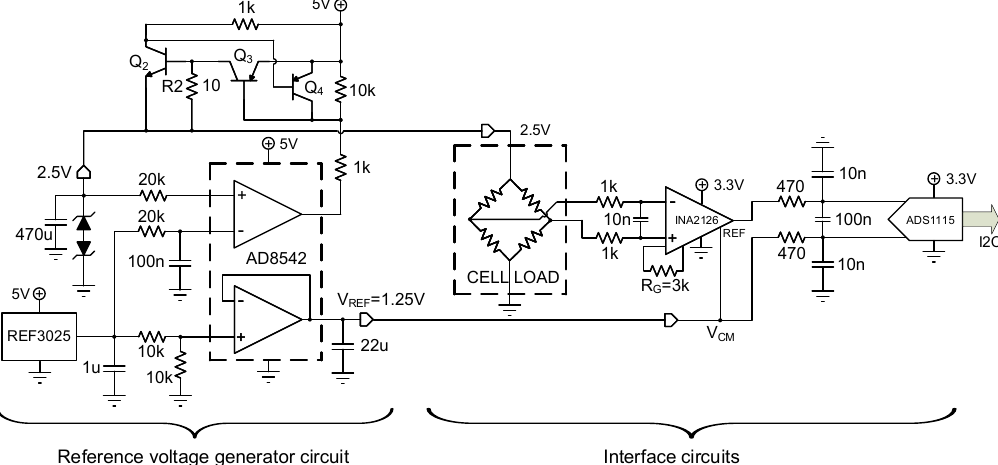
Figure 5. Signal conditioning circuit and A/D conversion: Reference voltage generator circuit (left) and Interface circuit